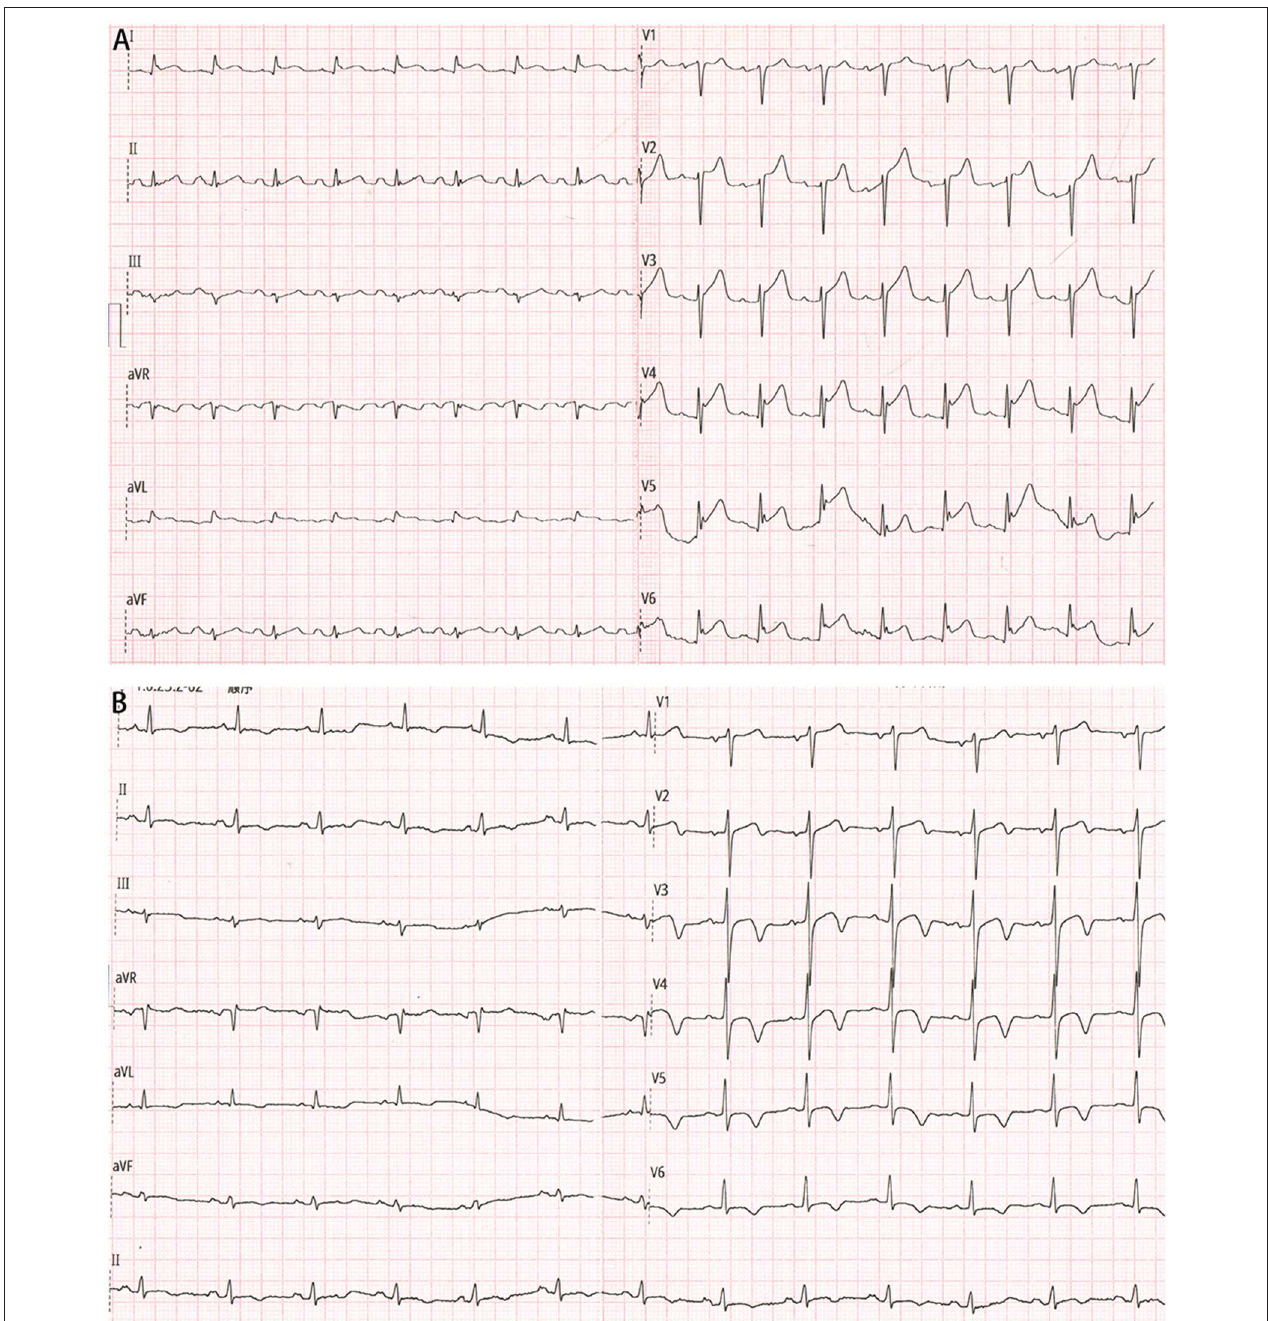
FIGURE 1 | (A) Electrocardiogram on admission showing ST-segment elevation in the precordial leads. (B) Electrocardiogram after percutaneous coronary intervention showing significantly improved ST-segment elevation